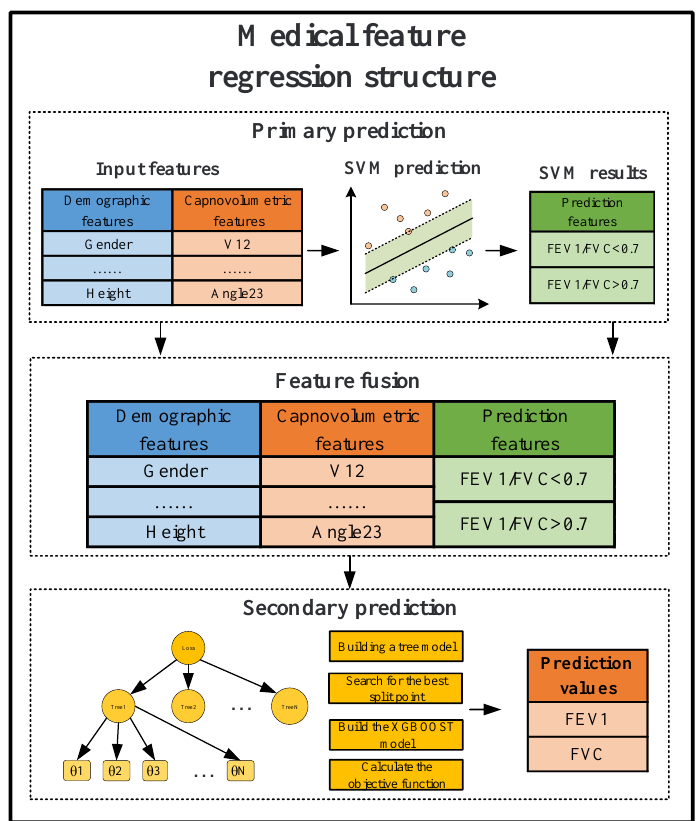
Figure 3. Structural flow chart of the medical feature regression structure.